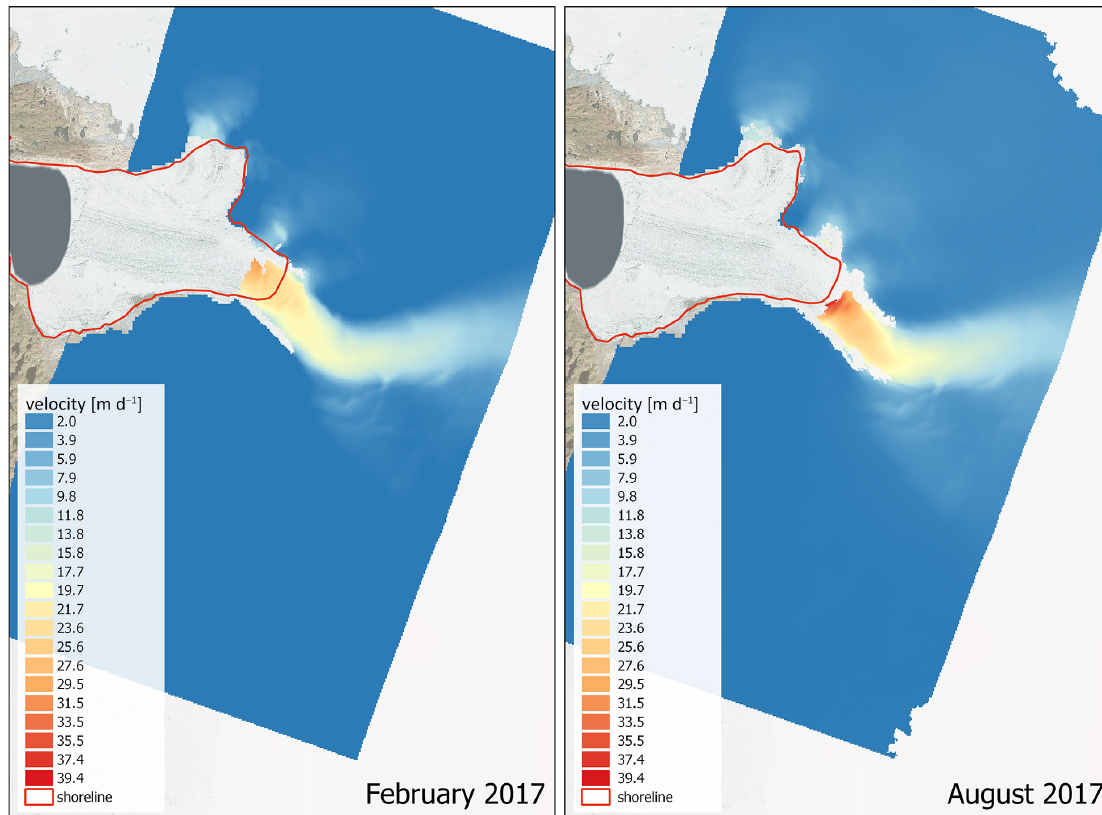
Fig. 2. Velocities of the Jakobshavn Glacier from the MEaSUREs